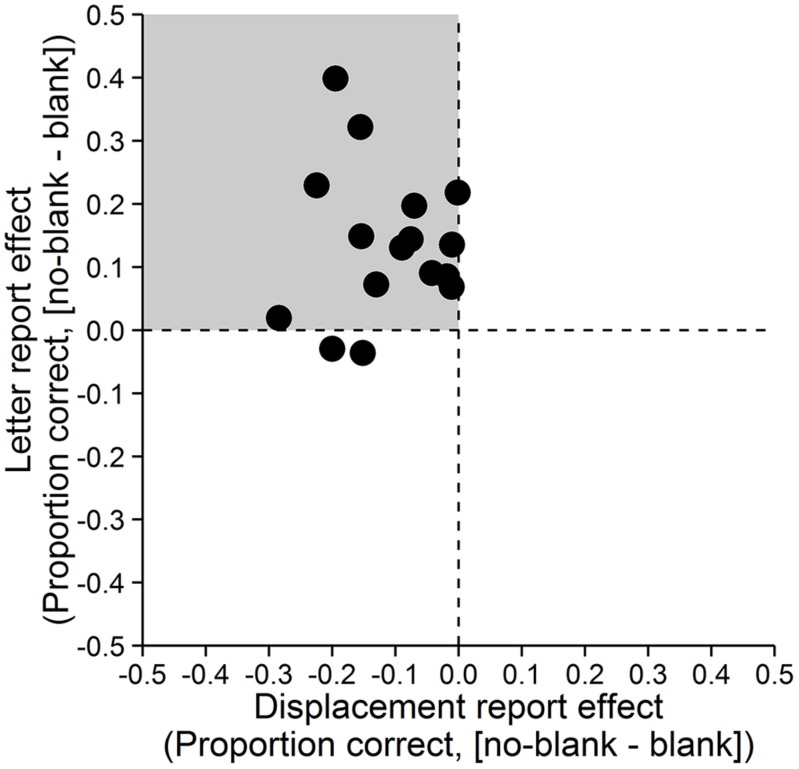
Effects of blanking on letter and displacement reports for individual observers. Differences between the no-blank and blank condition for both, displacement report (x-axis) and letter report (y-axis). Each point represents the value of one observer. The gray quadrant indicates the region in which points should fall if the effect of blanking on displacement report performance is in the opposite direction of the effect of blanking on letter report performance.